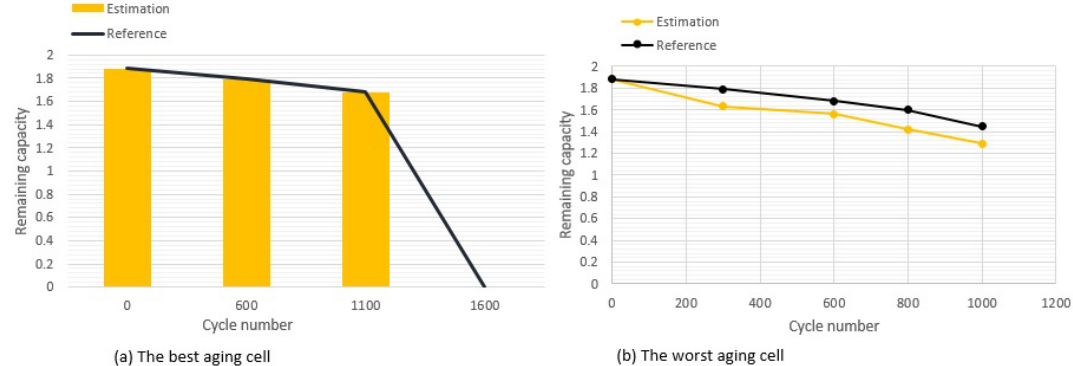
Figure 8. Comparison for estimate and reference.